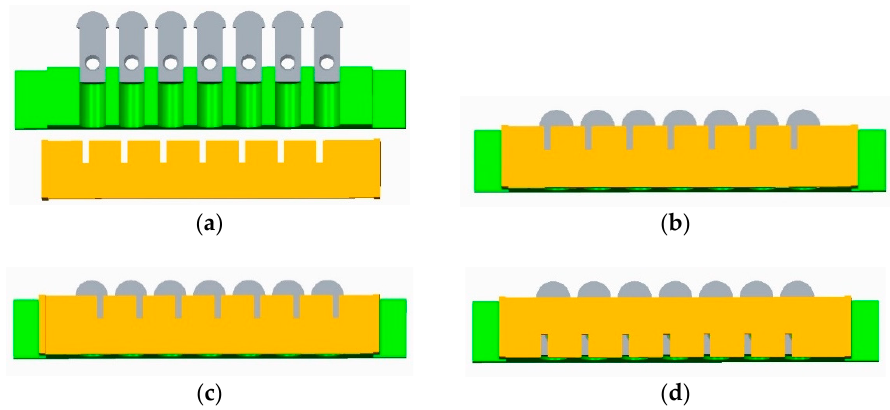
Figure 5. Installation method of the mask during coating process: ( a ) jig-base-mask installation diagram; ( b ) deposition NiCr functional film assembly drawing; ( c ) assembly drawing of deposited NiSi functional film; ( d ) assembly drawing of deposited SiO 2 protective film.